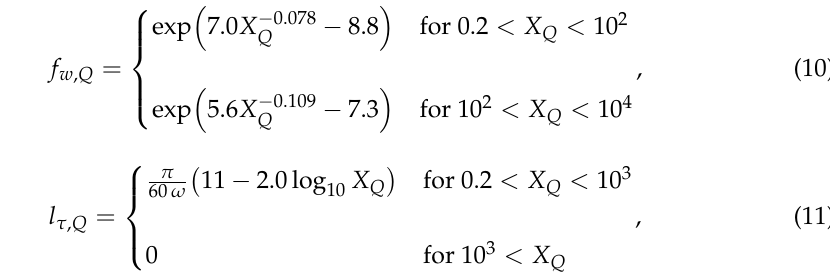
quantities in sediment transport rate calculations. In the quasi-steady approach, f w , Q and l τ , Q are calculated as constants throughout the wave cycle [68]